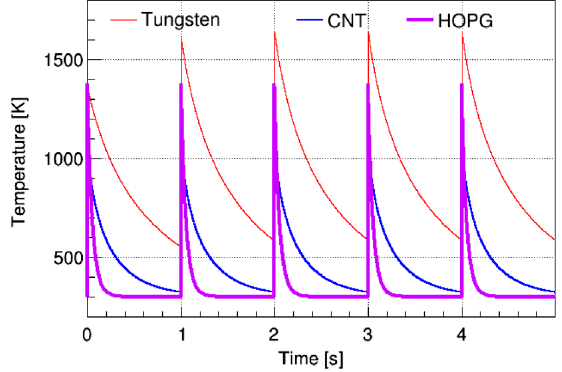
FIG. 1. Temperature estimation on target with beam irradiation calculated using the fourth-order Runge-Kutta method, where peak current, macrobunch length, and repetition frequency of beam are 55 mA, 50 μ s, and 1 Hz, respectively.